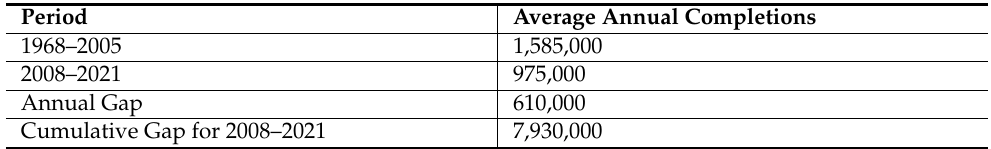
Table 3. Supply Shortfall Based on Historic Trends.